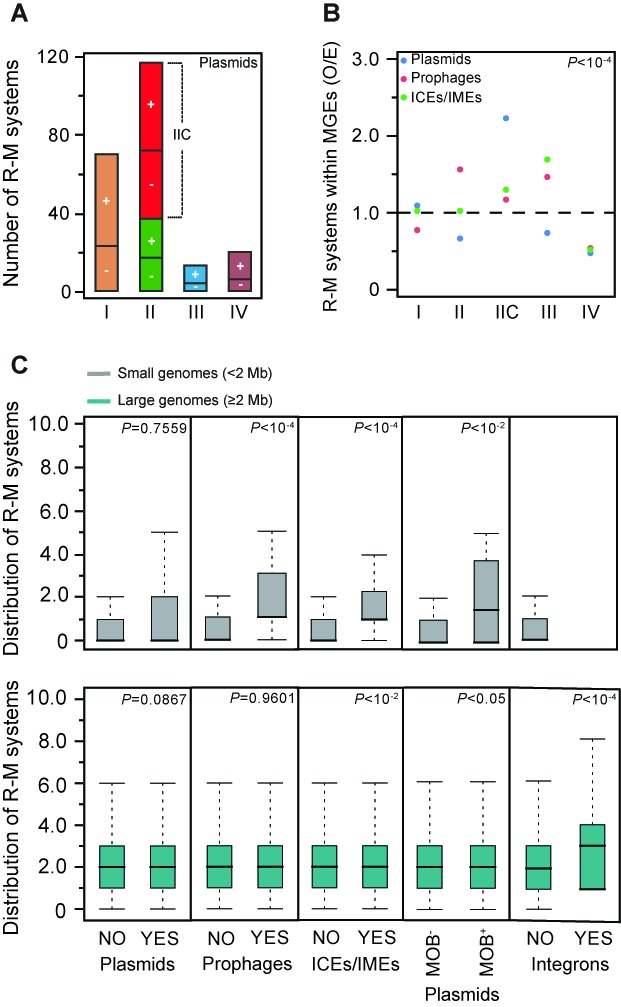
Quantification and distribution of R-M systems in MGEs. (A) Amount of Types I, II, IIC, III R-M systems and Type IV REases found in plasmids. The latter were classified according to their transmissibility: plasmids encoding the entire conjugation machinery or at least the relaxase (MOB+, shown as +), and plasmids lacking even the relaxase (MOB−, shown as −). (B) Observed/expected (O/E) ratios of R-M systems in plasmids, prophages and ICEs/IMEs. Expected values were obtained by multiplying the total number of each type of R-M system by the fraction of R-M systems assigned to each MGE. (C) Co-occurrence of R-M systems and MGEs. Box plots of the genomic co-occurrence of R-M systems with plasmids, prophages, ICEs/IMEs and integrons in small (<2 Mb) and large (≥2 Mb) genomes. Error bars represent standard deviations. Mann–Whitney–Wilcoxon test P values are indicated.